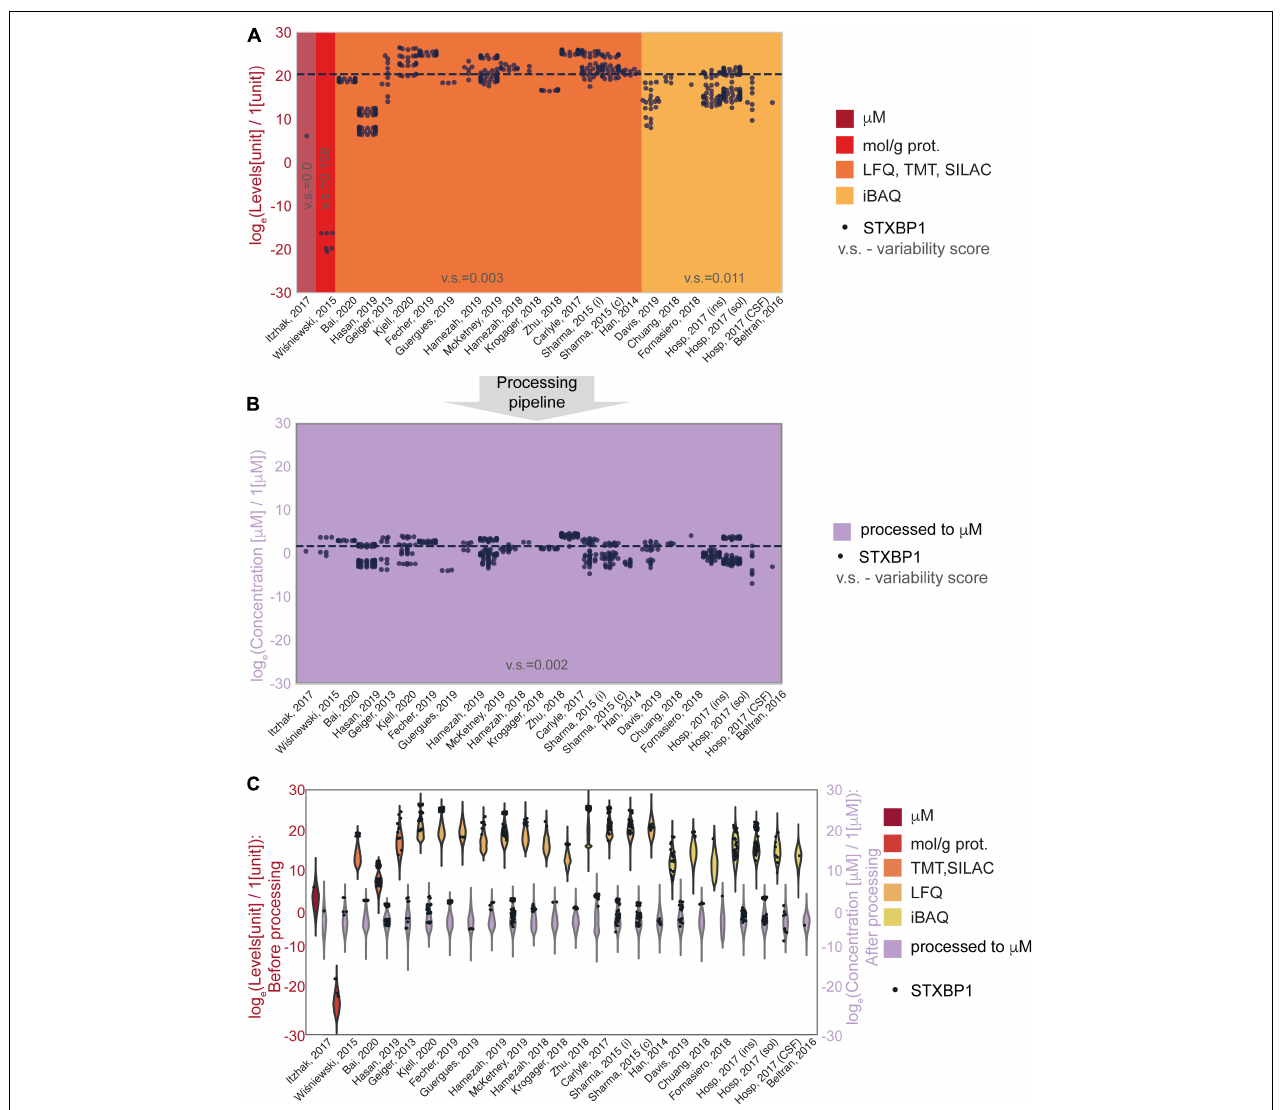
FIGURE 2 | An example of data before and after normalization for the experimental methods used to obtain the data. (A,B) STXBP1 protein (Syntaxin-binding protein 1) before (A) and after (B) methodological normalization. Horizontal line corresponds to the median value and is drawn at the level of 20.3 (A) and 1.57 a.u. (B) . STXBP1 was chosen for demonstration as the protein with the largest number of available measurements in the collected data among the proteins that are present in the largest number of data sets (590 entries from 24 data sets). Variability score is defined as an absolute value of the coefficient of variation of the data (no log transformation) scaled to the number of measurements of each protein in every data type. The data after methodological normalization is considered as one group for calculation of the variability score in panel (B) . (C) Protein levels in different data sets before and after normalization. Abbreviations: log e = natural logarithm, LFQ = label-free quantification; TMT = tandem mass tag; SILAC = stable isotope labeling by/with amino acids in cell culture; iBAQ = intensity-based absolute quantification. Sample sizes per data set are available from the Supplementary Presentation